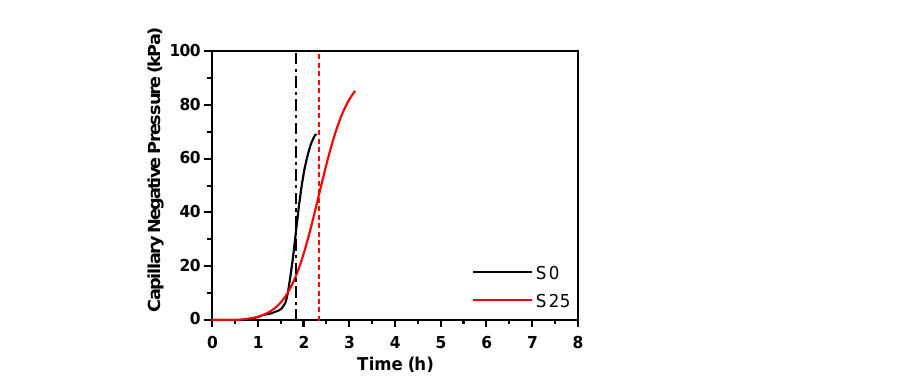
Figure 7. Relationship between deformation of concrete and the internal temperature and relative humidity during the steam curing stage.